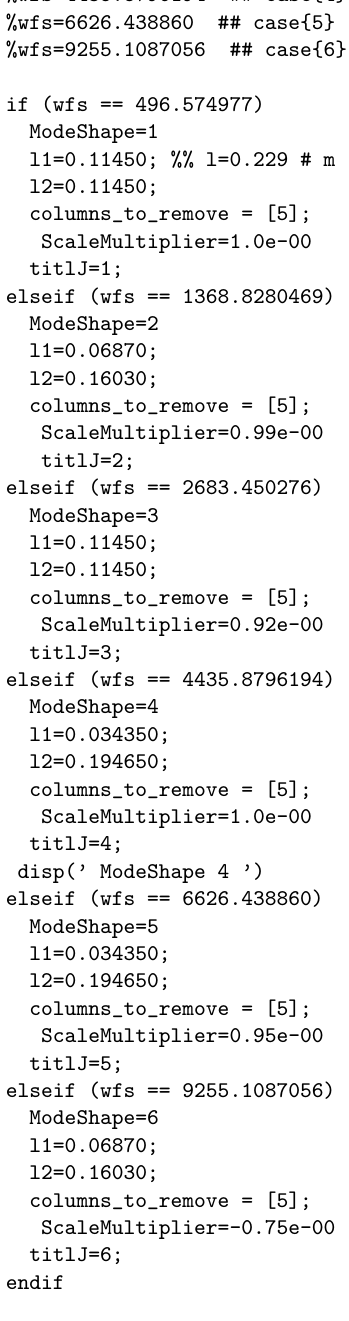
Figure 9 depicts the four displacement mode shapes of the fixed-fixed beam. Steady-state forced vibration can be represented by response curves [28] with the eigenvalues (saddle and star points) lying on the abscissa axis and the transversal displacement and elastic strain energy ampli- tudes on the ordinate axis [29, p.